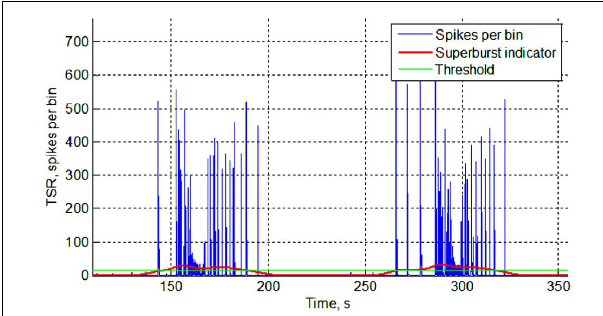
FIGURE 1 | Superburst detection. TSR (blue), total spiking rate over all electrodes in every consecutive 50 ms bin.The superburst indicator (red) reflects the cross-correlation of theTSR with a 50-s long Gaussian window. The estimated threshold for superburst detection is shown in green (for details, see Spontaneous Activity